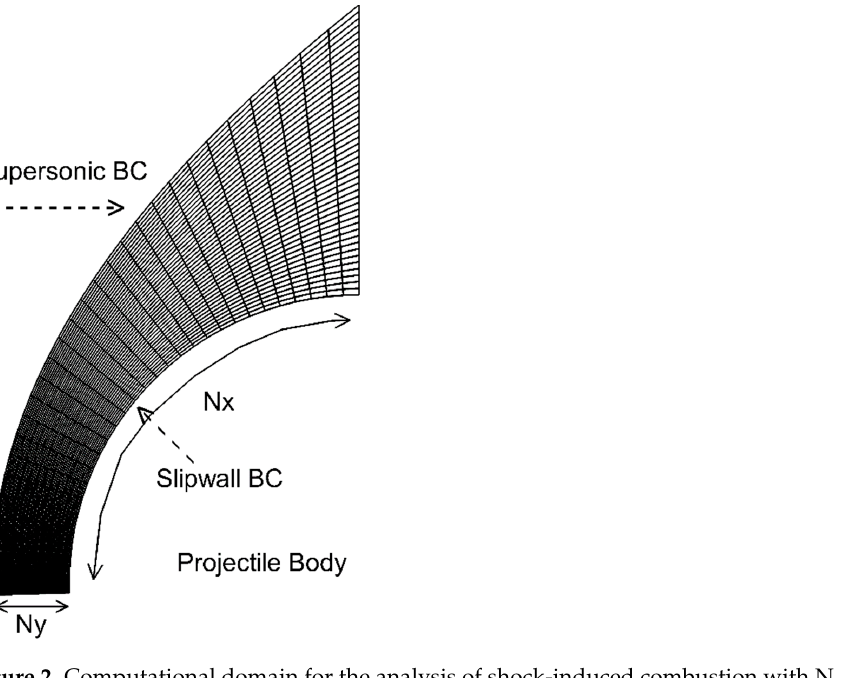
Figure 2. Computational domain for the analysis of shock-induced combustion with N x × N y grid system.